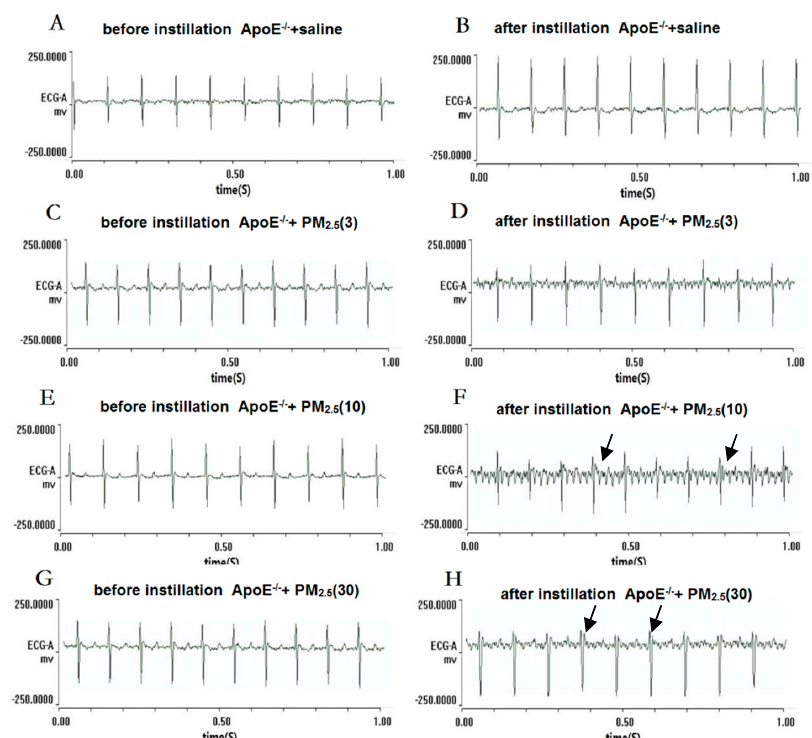
Figure 2. Electrocardiogram (ECG) types before instillation and after instillation in ApoE − / − mice. ( A , C , E , G ) represent the ECG in the mice before PM 2.5 treatment; ( B , D , F , H ) represent the ECG in the mice after PM 2.5 treatment, the doses were 0, 3, 10, and 30 mg/kg b.w., respectively; ( F ) black arrows represent left bundle-branch block; and ( H ) black arrows represent right bundle-branch block (RBBB).